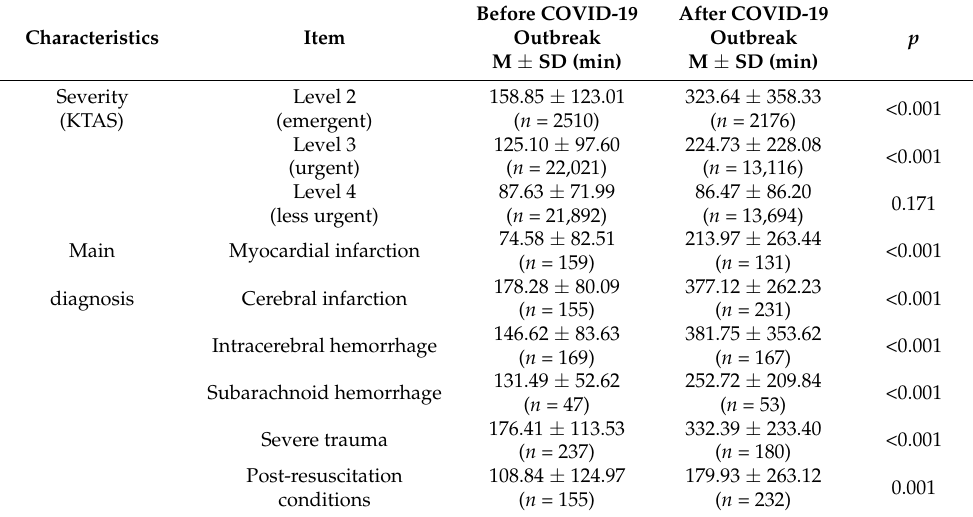
Table 3. The difference in the emergency department length of stay (EDLOS) by severity before and after COVID-19